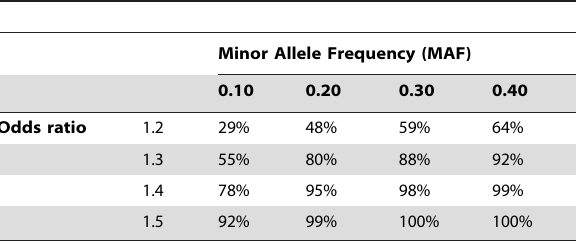
Table 5. Study power to detect various odds ratios for selected minor allele